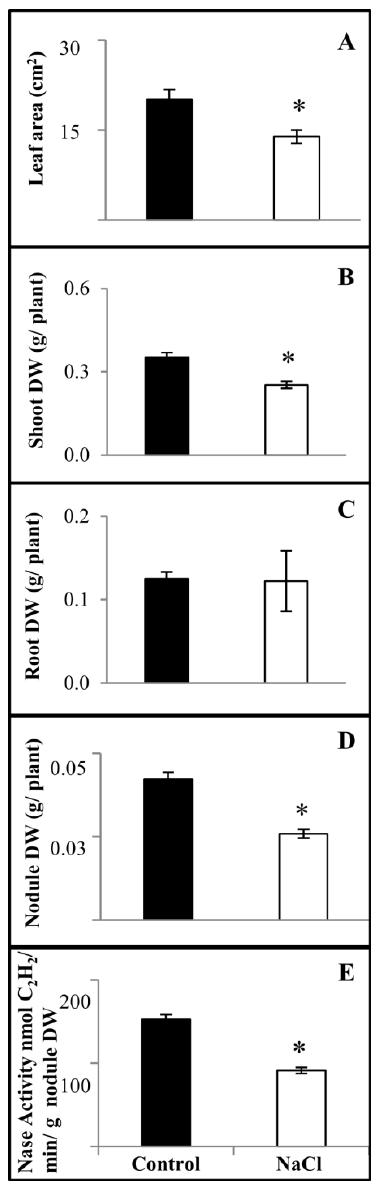
Figure 4. Effect of salinity on SNF common bean plants. Cultivar CC-25-9-N plants were inoculated with Rhizobium tropici CIAT899 and were grown under control (black bars) or saline (15 mM NaCl, white bars) conditions. Leaf area ( A ), shoot ( B ), root ( C ) and nodule ( D ) dry weight and nitrogenase specific activity (acetylene reduction assay) ( E ) were determined at 15 dpi. Values represent the average ± SD from three ( A − C ) or ten ( D , E ) biological replicates from different plant sets. Asterisks indicate significantly different means between plants grown under salinity vs. control treatments (Student’s t -test, p ≤